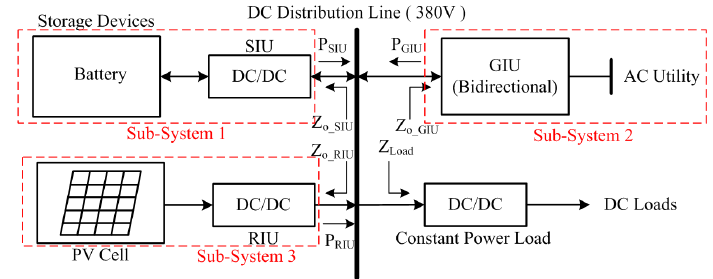
Figure 1. Block diagram of the proposed (DC) distributed microgrid system.